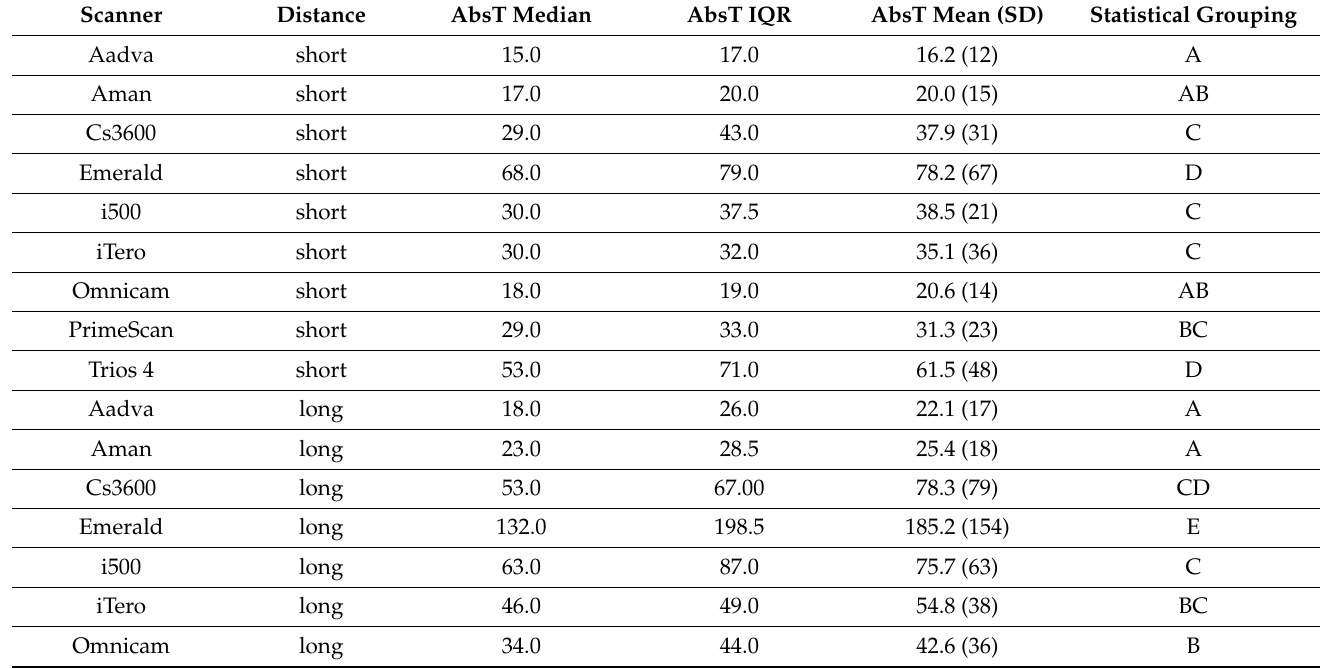
Table 5. Descriptive statistic values of median, interquartile range (IQR), mean, and standard deviation (SD) for precision ( µ m). Groups with the same letter in the same distance are not statistically